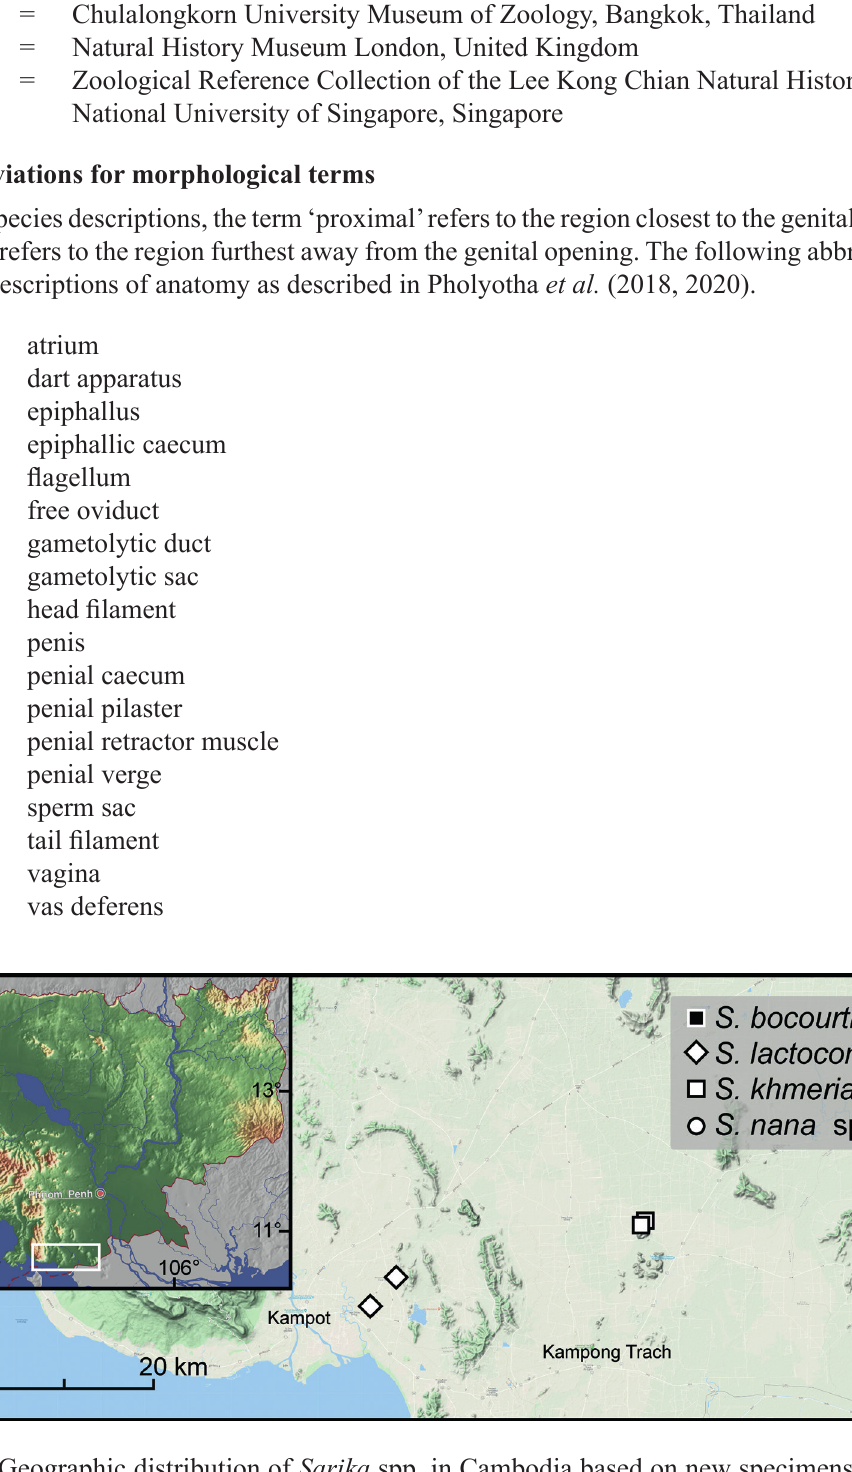
Fig. 1. Geographic distribution of Sarika spp. in Cambodia based on new specimens examined herein. (modified from GinkgoMaps-project